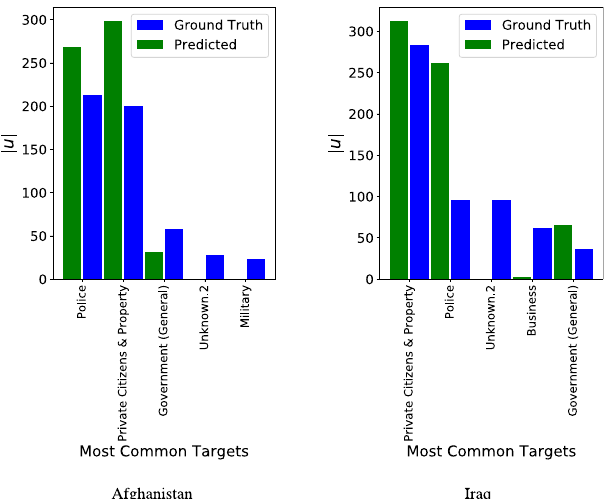
Figure 8. Bar chart comparing the number of time units | u | a feature was empirically ranked among the two highest centrality values in the test set and number of times the same feature was forecasted among the two highest centrality values. The graph reports the result for the model with the highest Ŵ for Afghanistan and Iraq, respectively (Afghanistan: Bi-LSTM with 30 as input width; Iraq: Bi-LSTM with 5 as input width) and shows the five most common targets in each dataset. The figures have been created using Matplotlib version 3.1.3. https:// matpl otlib. org/3. 1.3/ conte nts.